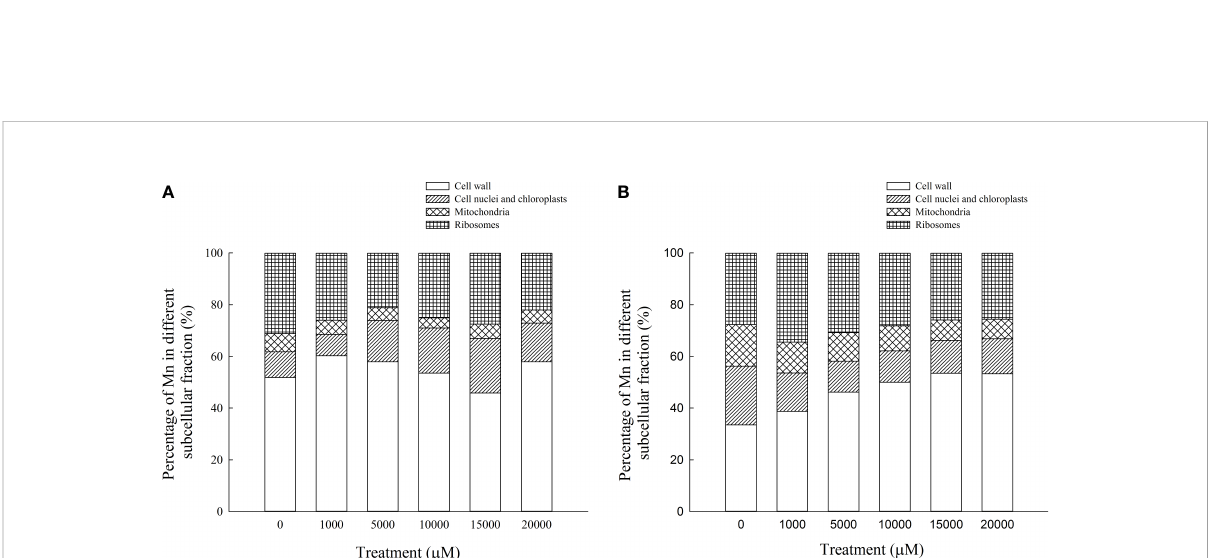
FIGURE 6 Percentages of subcellular distribution of Mn in aboveground part (A) and underground part (B) of D carota under different Mn